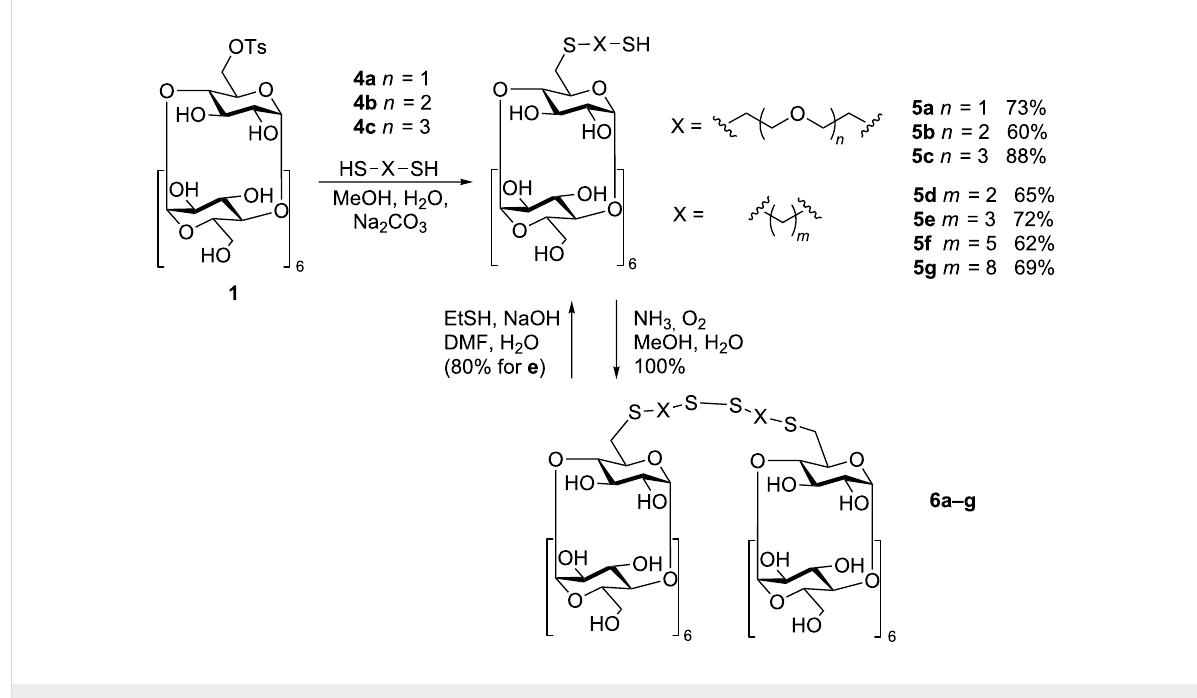
Scheme 2: Synthesis of β -cyclodextrinthiols and